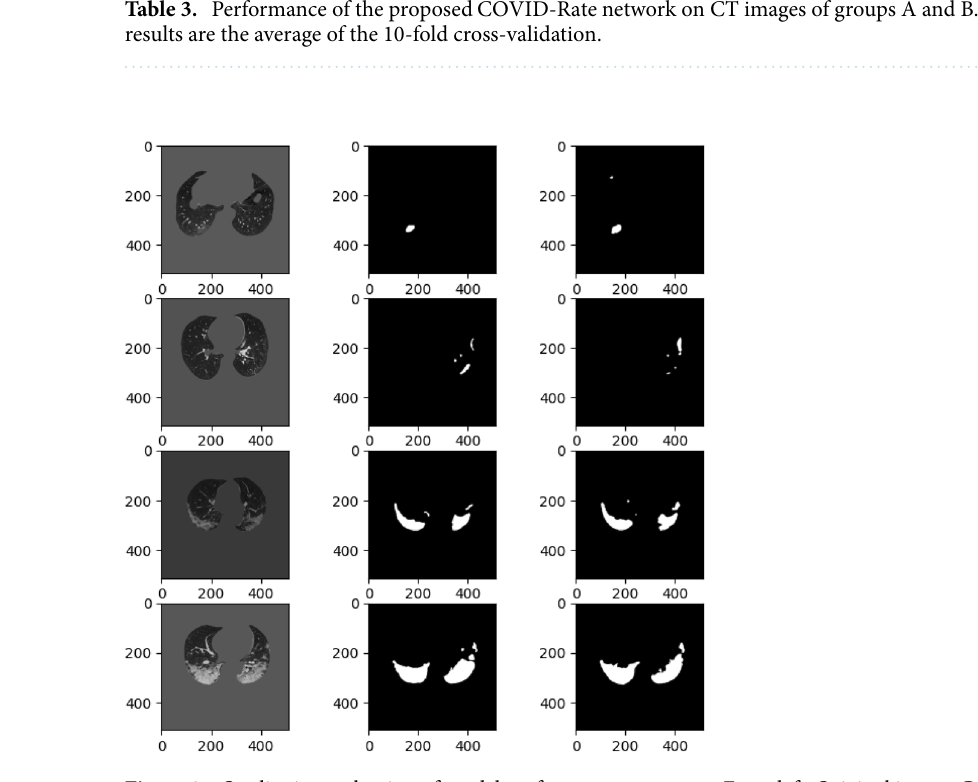
Figure 9. Qualitative evaluation of model performance on test set. From left: Original image, Ground truth mask, Predicted mask. Row 1 and 2: Test images from group A with infection rate less than 0.015, Row 3 and 4; Test images from group B with infection rate more significant that